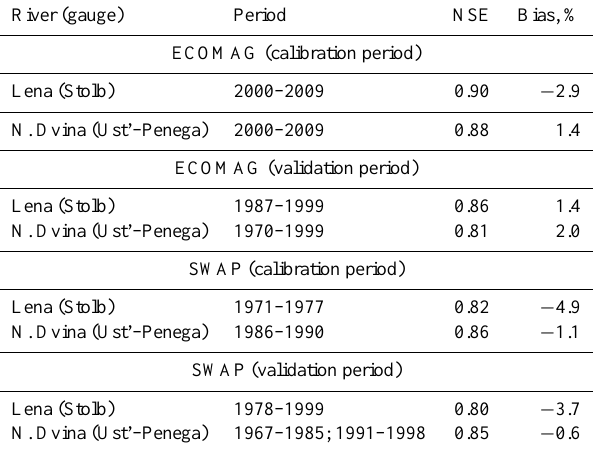
Table 1. The Nash and Sutcliffe efficiency, NSE, and bias eval- uation criteria calculated from simulated and measured daily dis- charge at the outlets of the Lena and Northern Dvina river